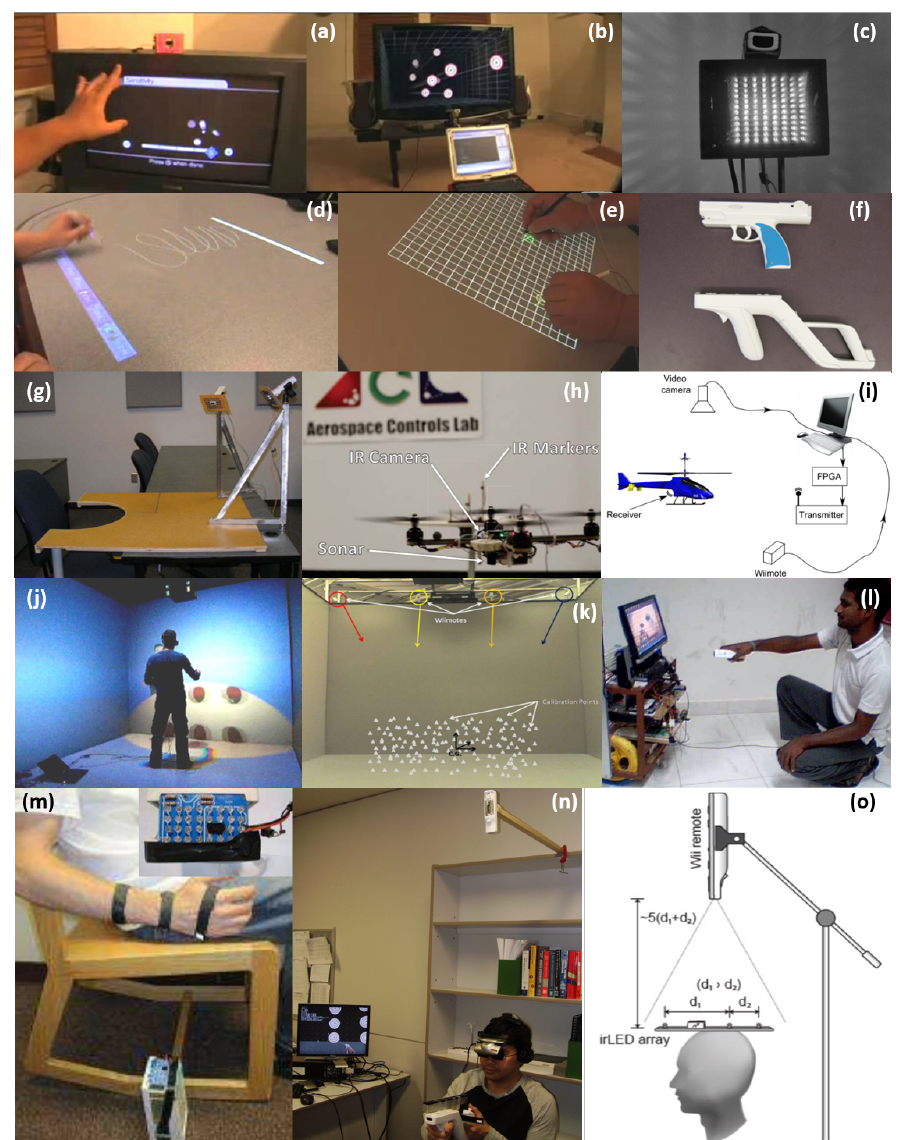
Figure 2. Various applications of the Wiimote: ( a ) a finger tracking; ( b ) a head tracking for VR (virtual reality) displays; ( c ) an IR-optical tracking system; ( d ) and ( e ) an interactive whiteboard; ( f ) an IR gun; ( g ) and ( m ) a rehabilitation device; ( h ) quadcopter application; ( i ) small UAV tracking; ( j ) cave-like environment VR; ( k ) automated assembly; ( l ) human-robot interaction; ( n ) head display for VR; ( o ) indoor